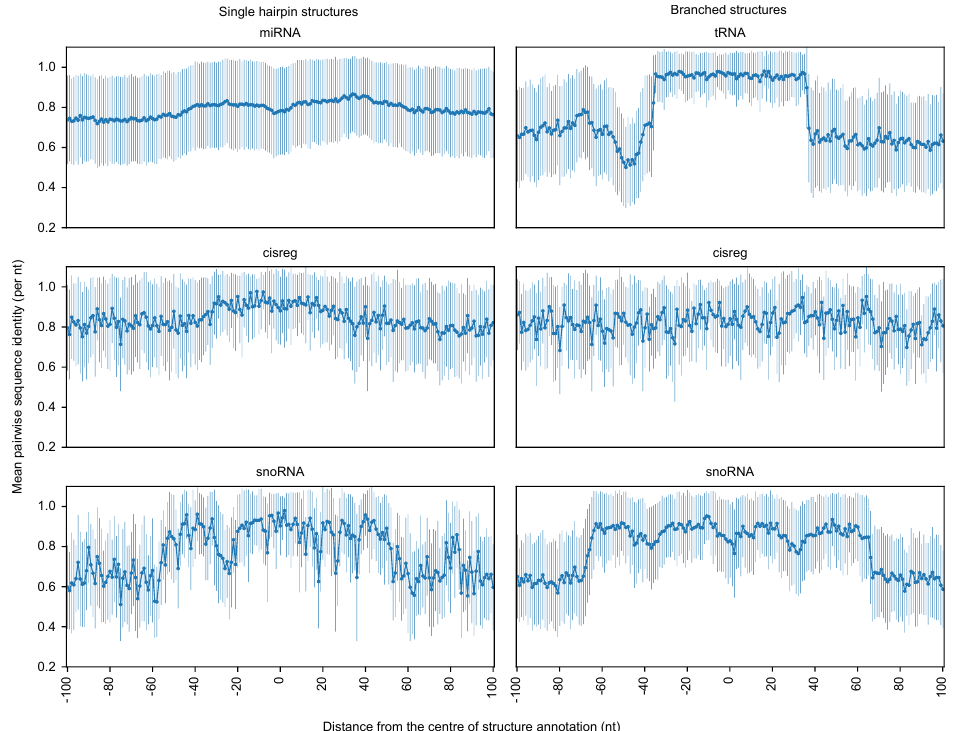
Figure 5. The mean pairwise sequence identity of each position along the multiple sequence alignment is shown for window size 200 nts. The x-axis represents each position along the multiple sequence alignment, and the y-axis represents the mean pairwise sequence identity computed per position in an alignment corresponding to each Rfam family. The circle indicates the mean of all mean pairwise sequence identities and vertical lines represents the standard deviation for each position on the x-axis. In case of alignments longer than the window size (200 nts), due to gaps introduced in the human sequence, we ignored the gapped columns for the sequence identity calculation. In addition, columns that contain greater than 25% bases as gaps are ignored in this